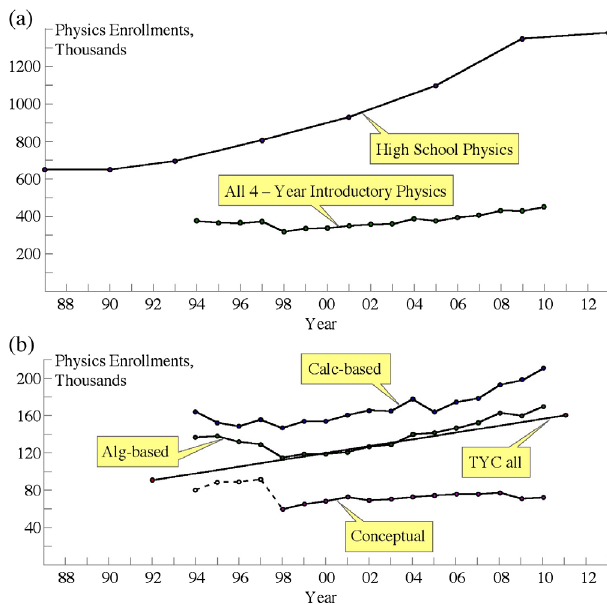
FIG. 1. (a) High school physics enrollment compared to physics enrollment at colleges and universities. (b) Enrollment in university courses broken down by type of course. Data for both graphs are from AIP